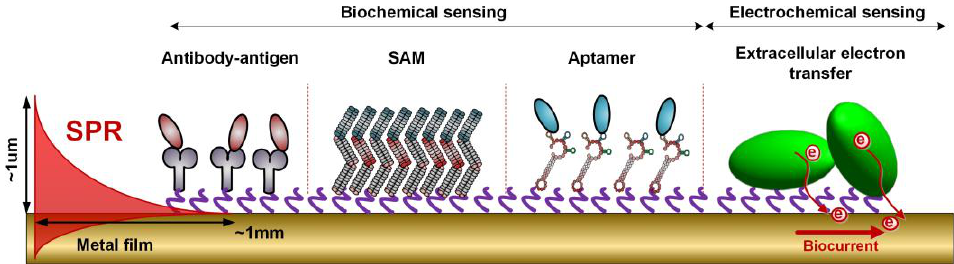
Figure 9. Sketch of a typically biofunctionalized metal-coated optical fiber surface, showing the different strategies that are most often used to attract analytes.